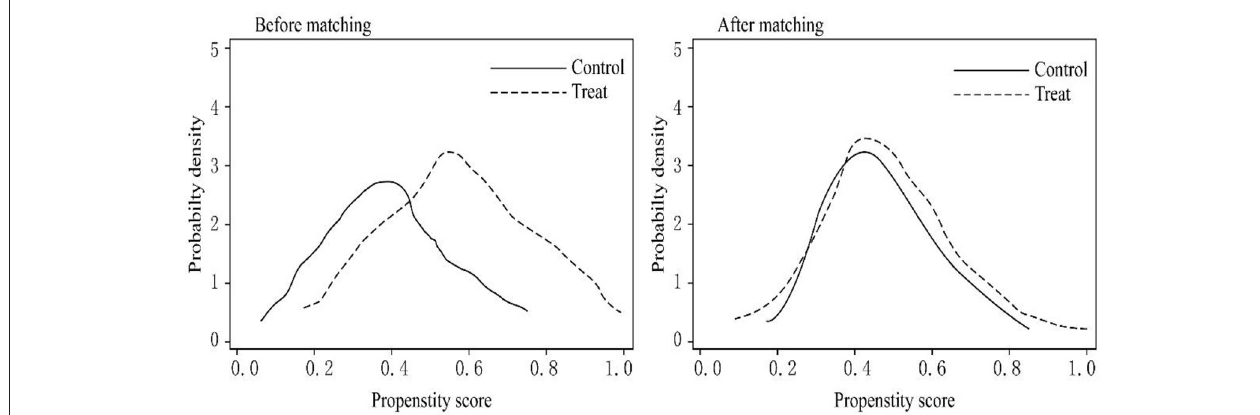
FIGURE 1 | Common support domain of control and treat groups.